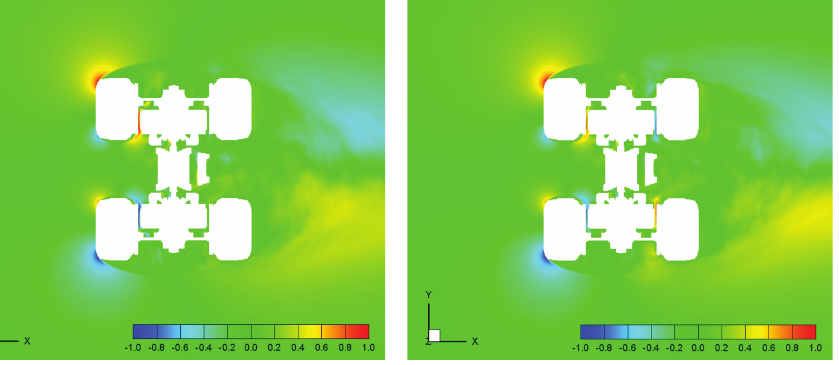
Figure 19: Computed mean velocity component at cross section z = − 2 . 21 ( left: BACK TEAR, right: BACK SEAL). Three LEG configurations with forward/backward and link position: BACK TEAR, FRONT TEAR, NO